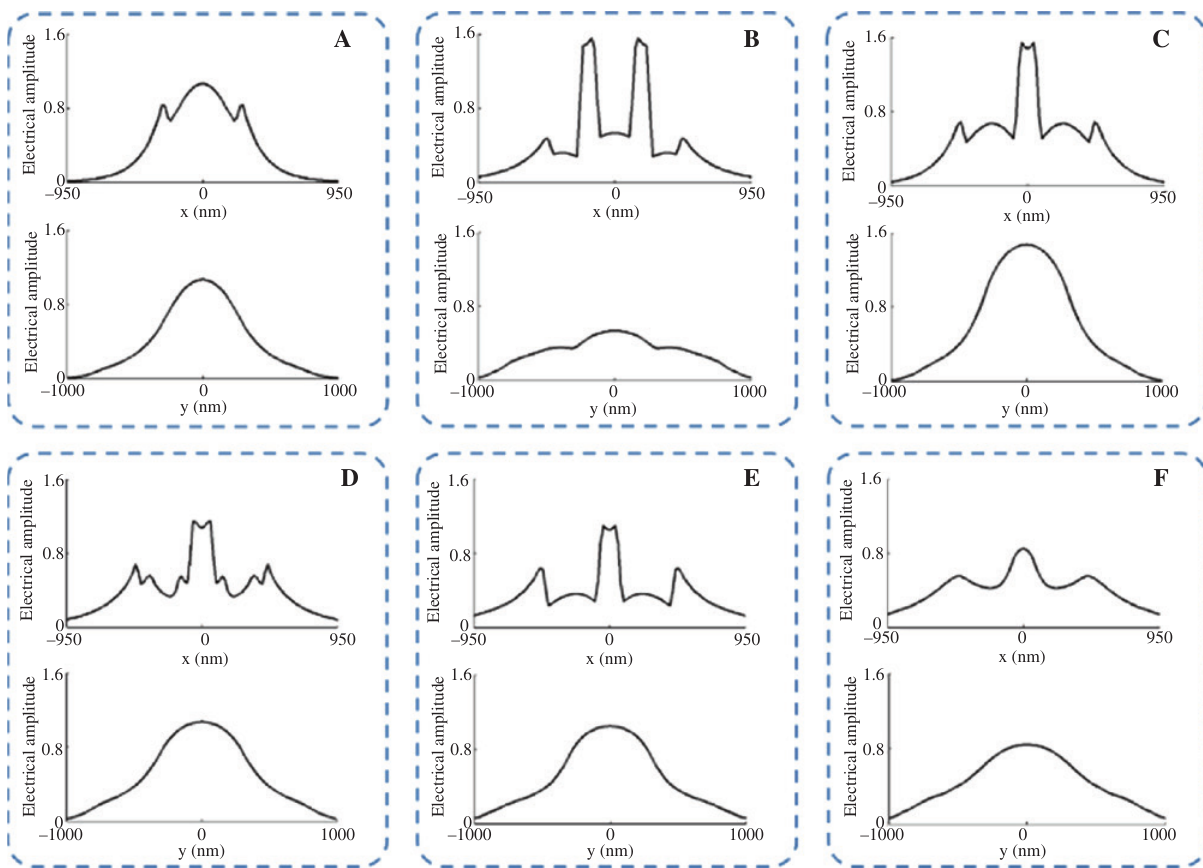
Figure 4: Simulated mode normalized intensities along the x and y directions of the guided and propagated fundamental TE mode in strip- to-SWGS mode converter. (A) Strip waveguide region. (B) Middle of the strip-to-slot mode converter. (C) Slot waveguide region. (D) Middle of the slot-to-SWGS mode converter. (E) Si segment of SWGS waveguide. (F) SiO segment of SWGS 2